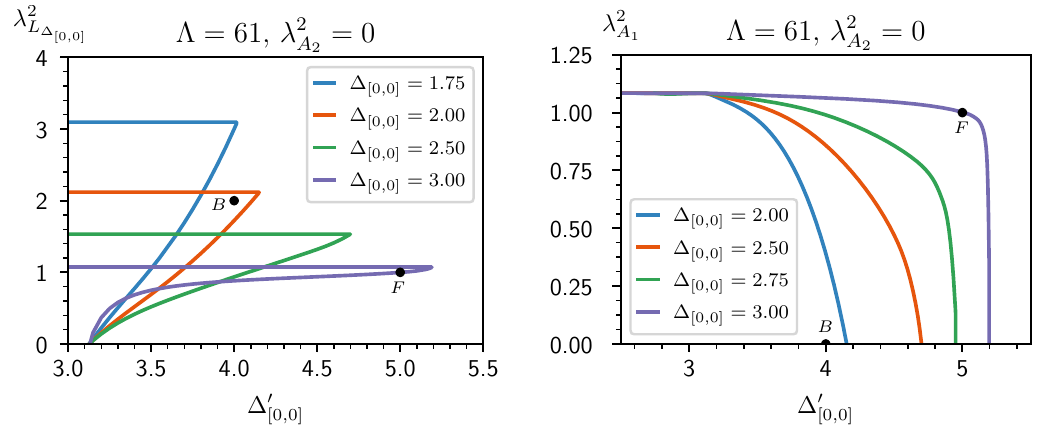
Figure 5 . Comparison of the upper and lower bounds of (cid:21) 2 of (cid:1) 0 and for di(cid:11)erent values of (cid:1) [0 ; 0] assuming (cid:21) 2 = A 2